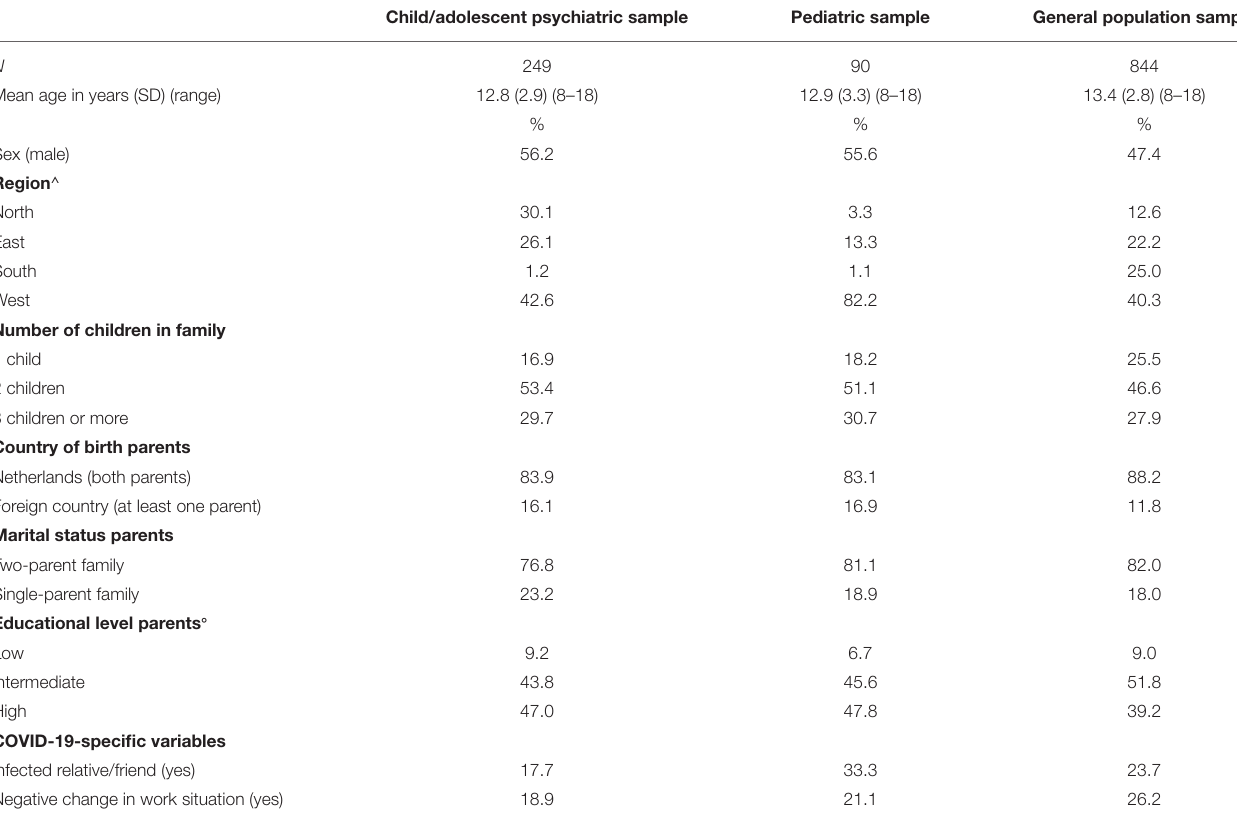
TABLE 1 | Socio-demographic characteristics of participants per group.